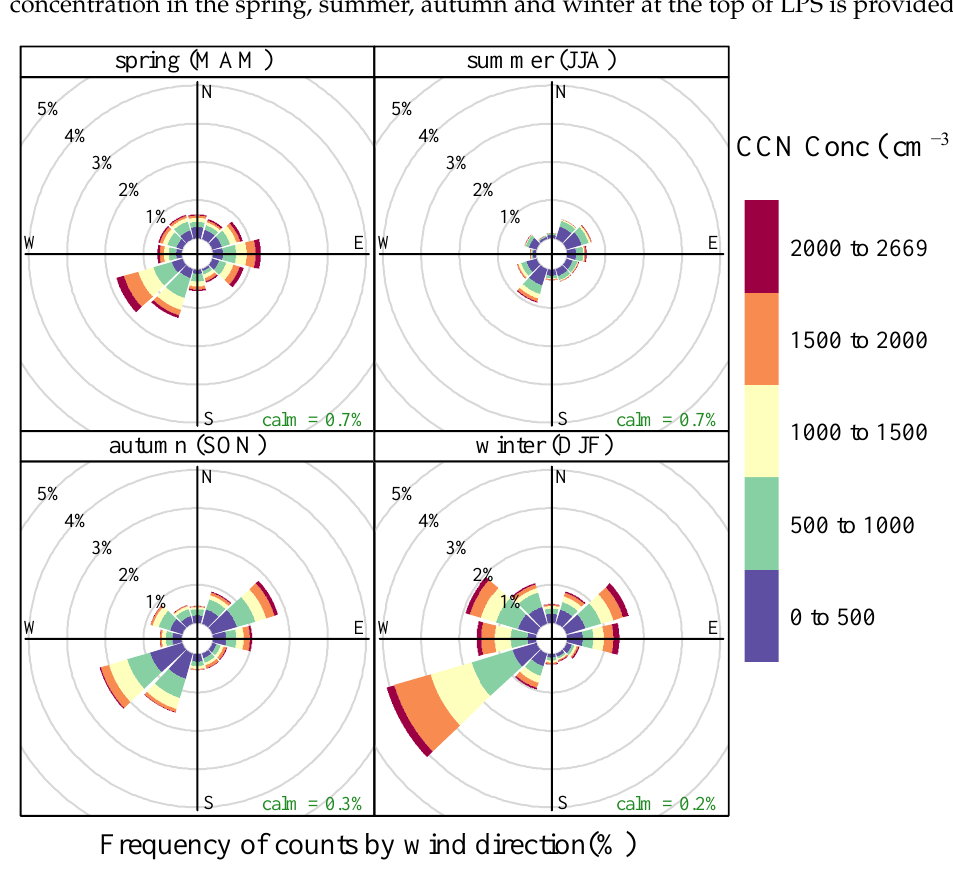
Figure 7. Contribution of four seasonal wind directions to CCN concentration.